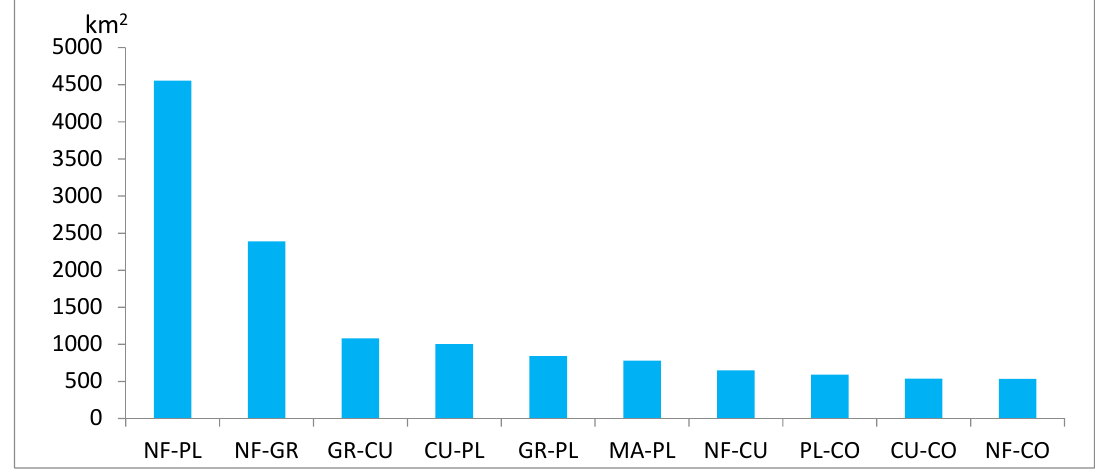
Figure 12. Area of the land use change types.